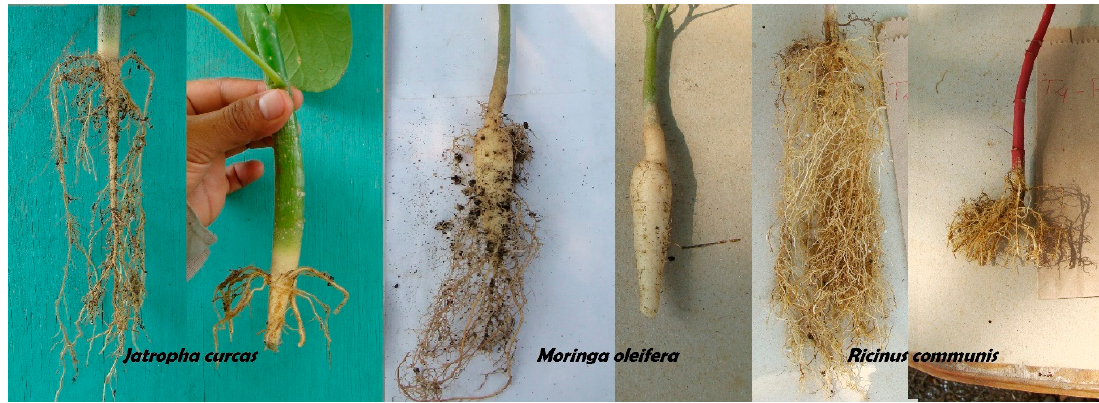
Figure 1. Roots of 63-day-old Jatropha curcas , Moringa oleifera , and Ricinus communis before and after pruning.